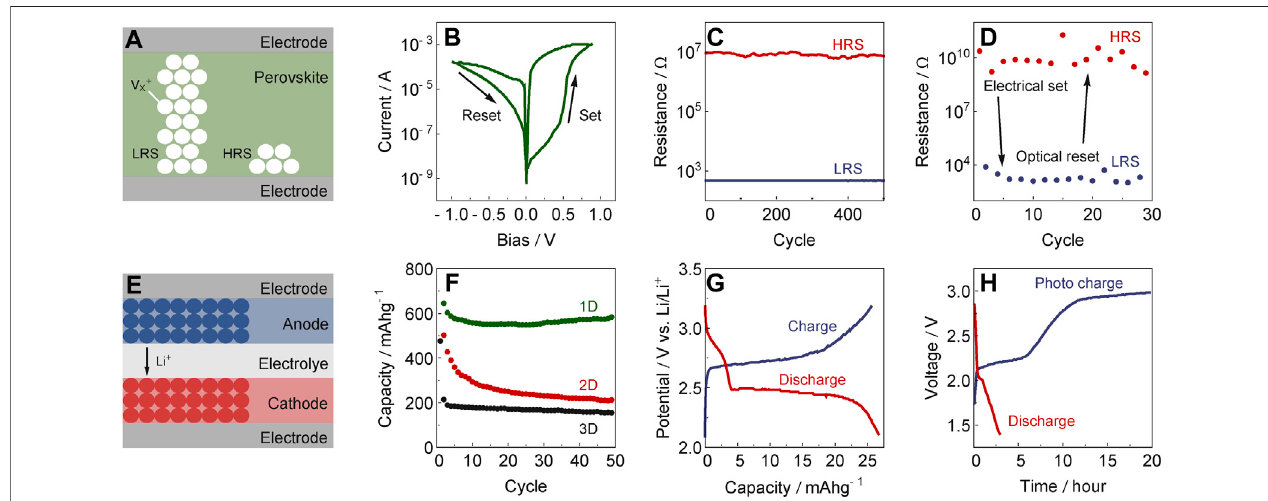
FIGURE 2 | Hybrid halide perovskites as (A – D) resistive switches and (E – H) rechargeable batteries. (A) Schematic representation of low resistance states (LRS) and high resistance states (HRS) as a result of the presence or absence of conductive fi laments from the contact electrodes or contributing ion vacancies (V X+ ). (B) Current-voltage characteristics and (C) endurance test for 500 switching cycles of a resistive switch. Adapted from (Solanki et al., 2020). (D) Light-tunable resistance switch set by an electric pulse and reset by a light pulse. Adapted from (Zhu et al., 2017). (E) Schematic representation of a rechargeable battery. (F) Perovskite- based anode performance for rechargeable batteries based on different dimensionalities (1D, 2D and 3D). Adapted from (Tathavadekar et al., 2017). (G) Charge – discharge curves of perovskite-based cathodes. Adapted from (Jaffe and Karunadasa, 2014). (H) Charge – discharge curves of perovskite-based photocathode. Adapted from (Ahmad et al.,